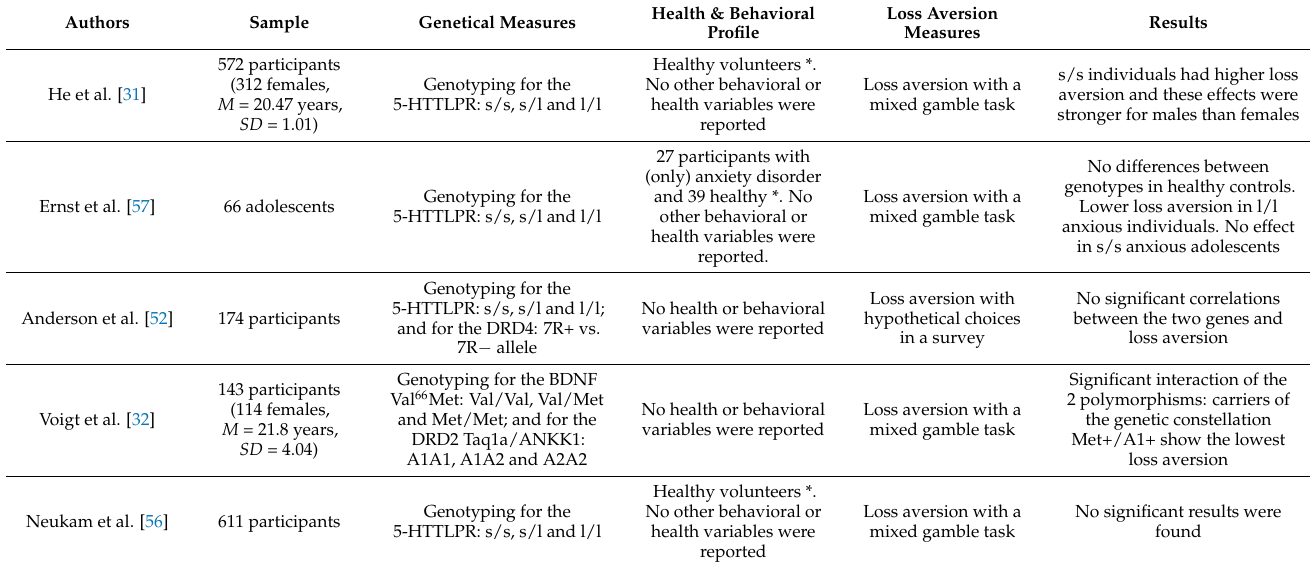
Table 2. Loss aversion.